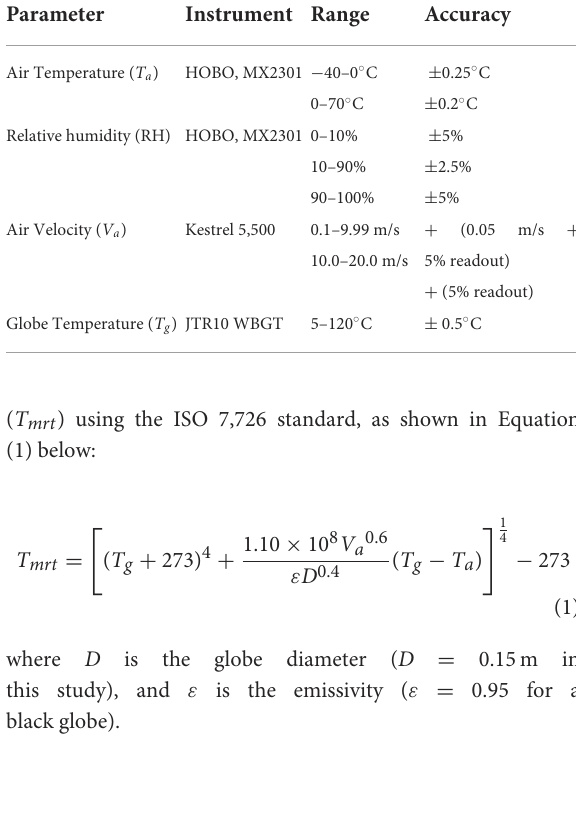
TABLE 2 Parameters considered in this study and the instruments used to measure them.